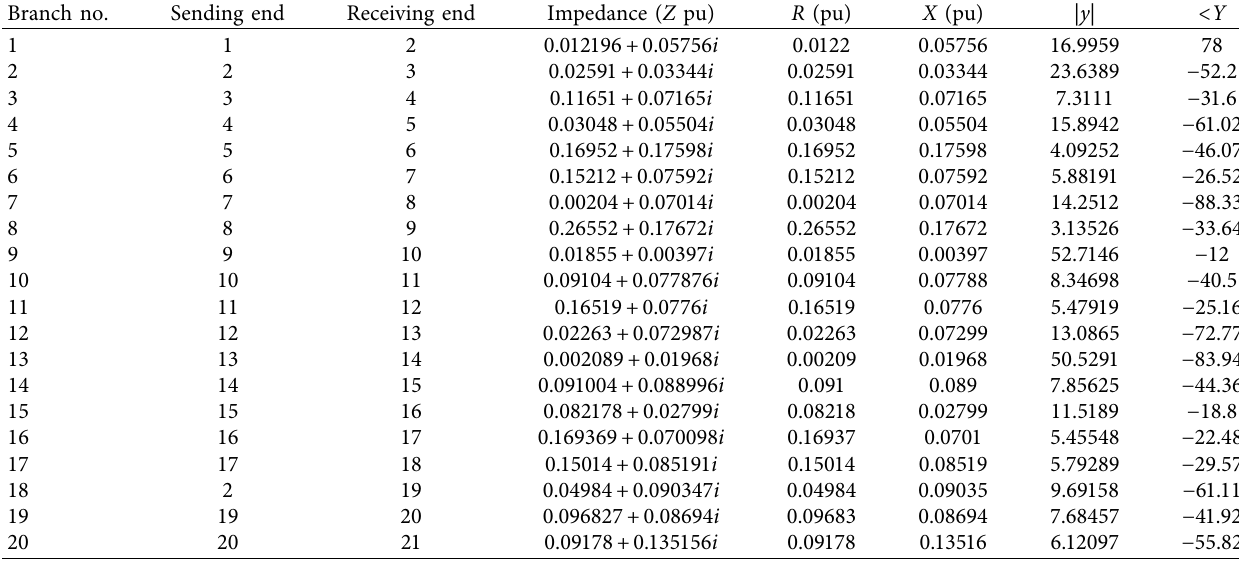
Table 6: Line impedance and admittance per unit on a distribution